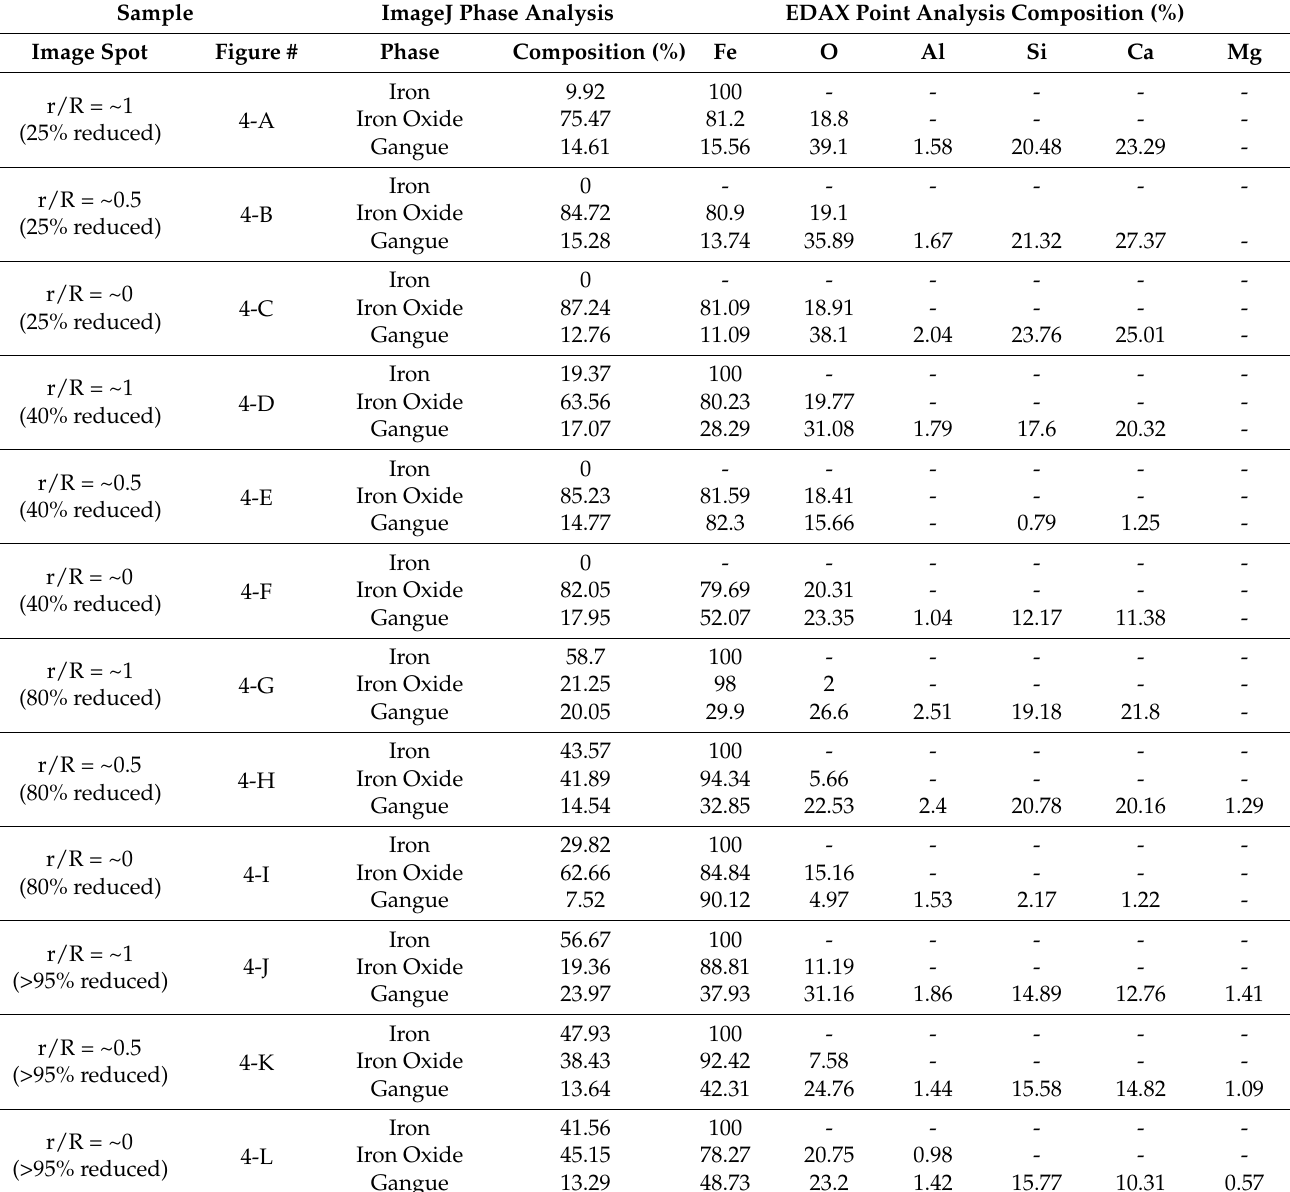
Table A1. Phase analysis and EDAX point analysis for SEM images (H 2 gas